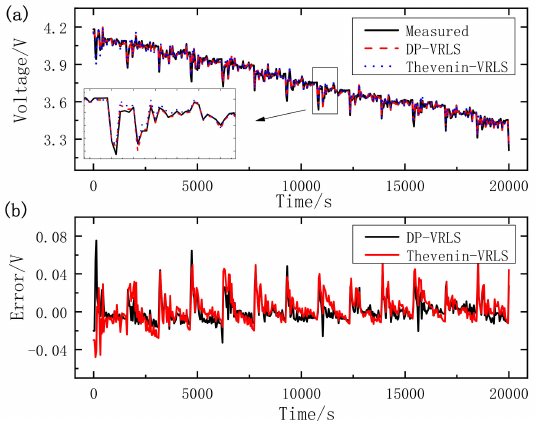
Figure 4. The estimated terminal voltages and corresponding errors based on different battery models under UDDS condition: ( a ) voltage comparison; ( b ) error of voltages.